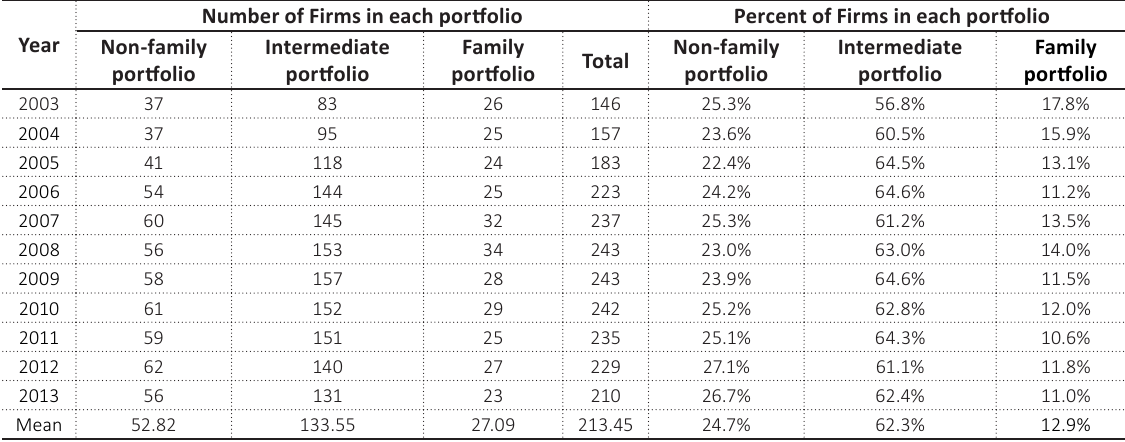
Table 2. Family and non-family portfolios